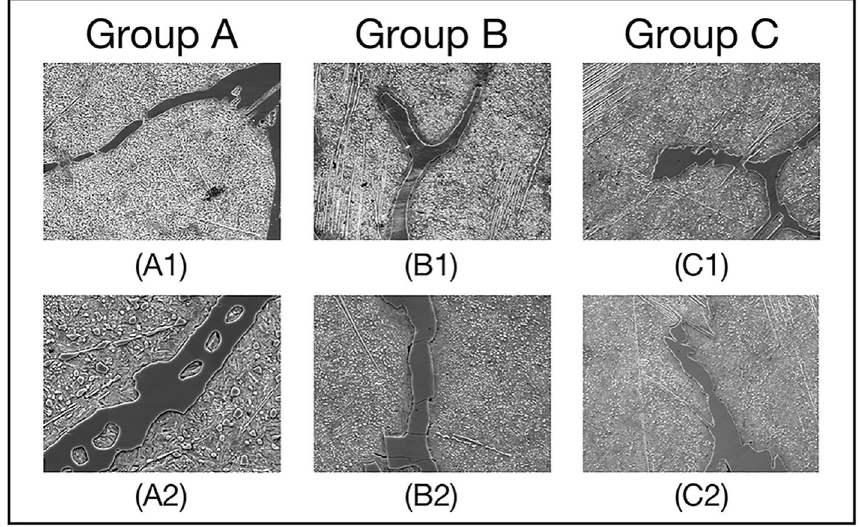
Figure 1. Division of data set in carbon steel images. Each group has two images. The primary microconstituent of ( A1 , A2 , B2 , C1 , C2 )is spheroidite, and the primary microconstituent of ( B1 ) is spheroidite and